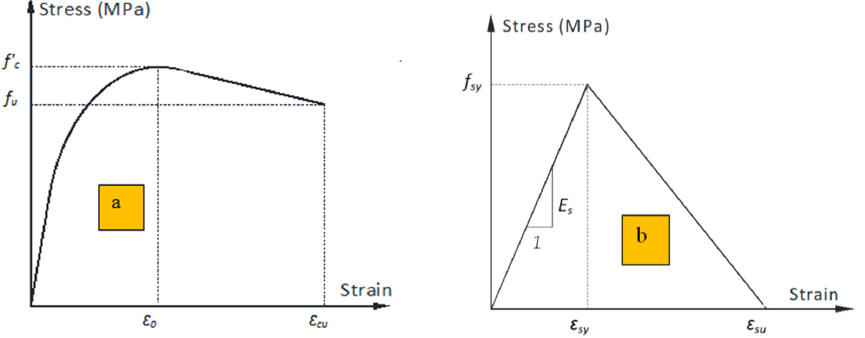
Figure 4. Concrete constitutive models for ( a ) compression and ( b )